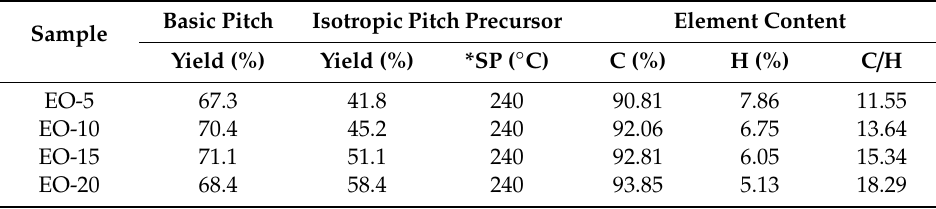
Table 1. Properties of isotropic pitch